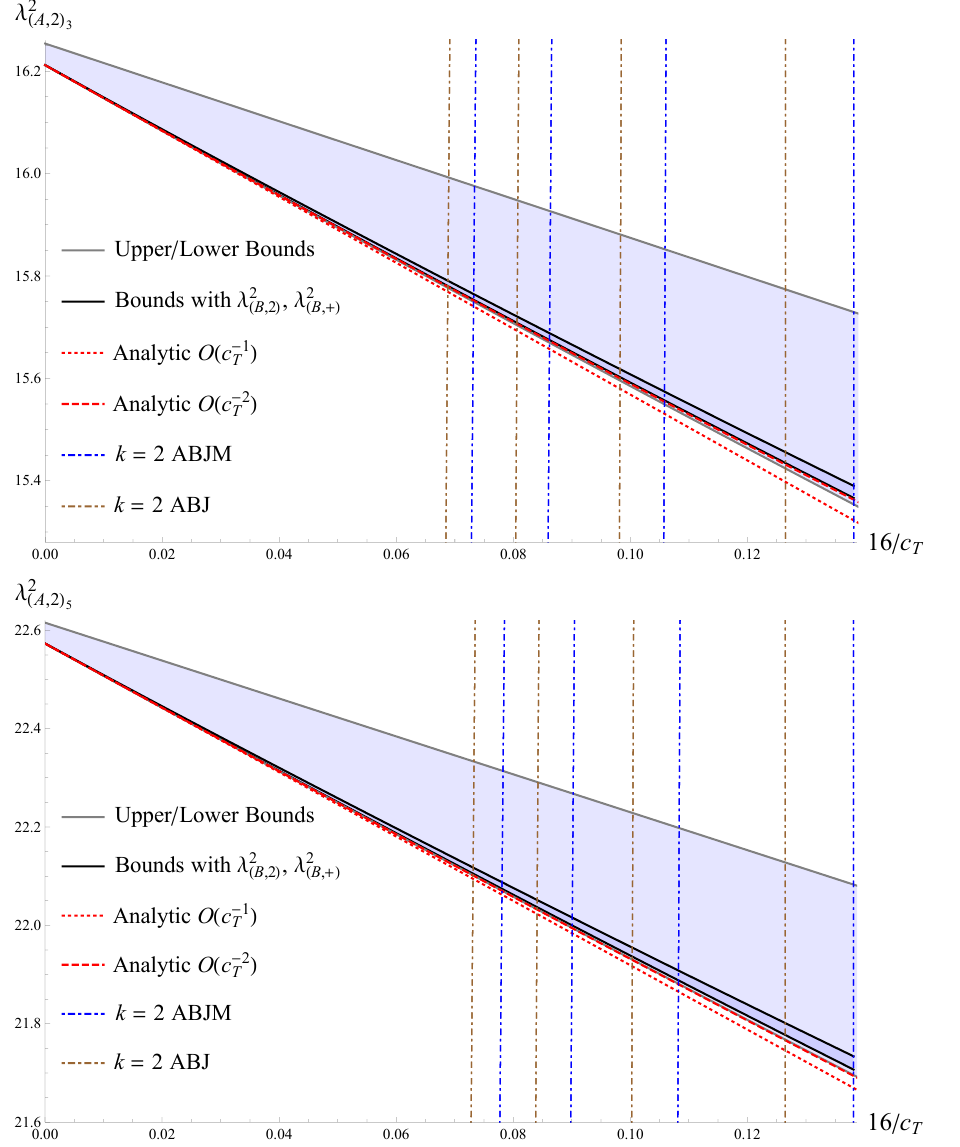
Figure 3 . Upper and lower bounds on the λ 2 (bottom) in terms of the stress-tensor coefficient c T in the large c T regime. The black solid lines are with the all orders in 1 /c T values of λ 2 bootstrap, while the gray solid lines are without any assumptions, and note that the allowed region for the black bounds is much smaller than the gray bounds. The red dotted line denotes the large c T expansion to order tree level supergravity O ( c − 1 line also includes the 1-loop R | R correction at order O ( c − 2 and improves the saturation of the lower bound relative to O ( c − 1 lines denote the values of c T for various known k = 2 ABJM and ABJ theories, respectively, which are summarized in table 4. These plots were made with Λ = 83